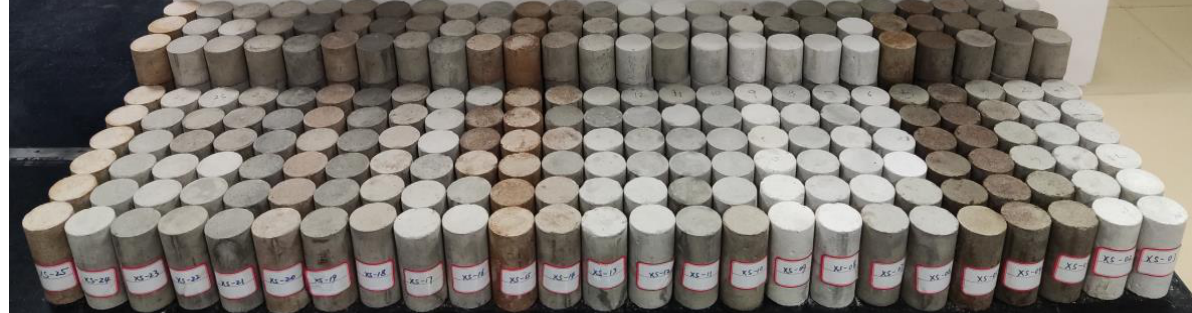
Figure 1. Samples of model materials.